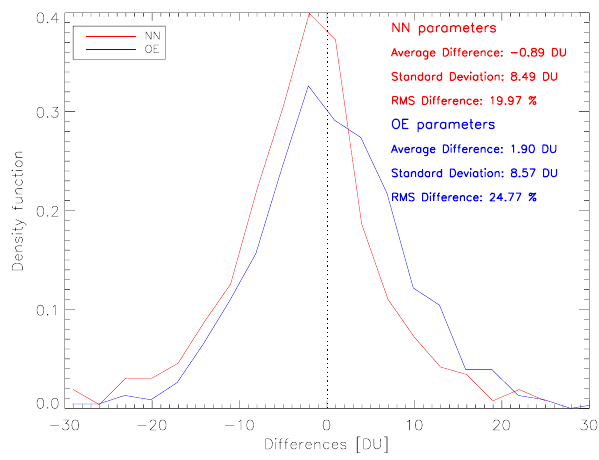
Fig. 5. Histogram of the absolute deviations of OMI-TOC NN (in red) and OE TOC (in blue) retrievals from the OS reference values for the test data set. OE TOCs are derived from the algorithm de- scribed in Liu et al. (2010b). Statistical parameters are also reported in red and blue,